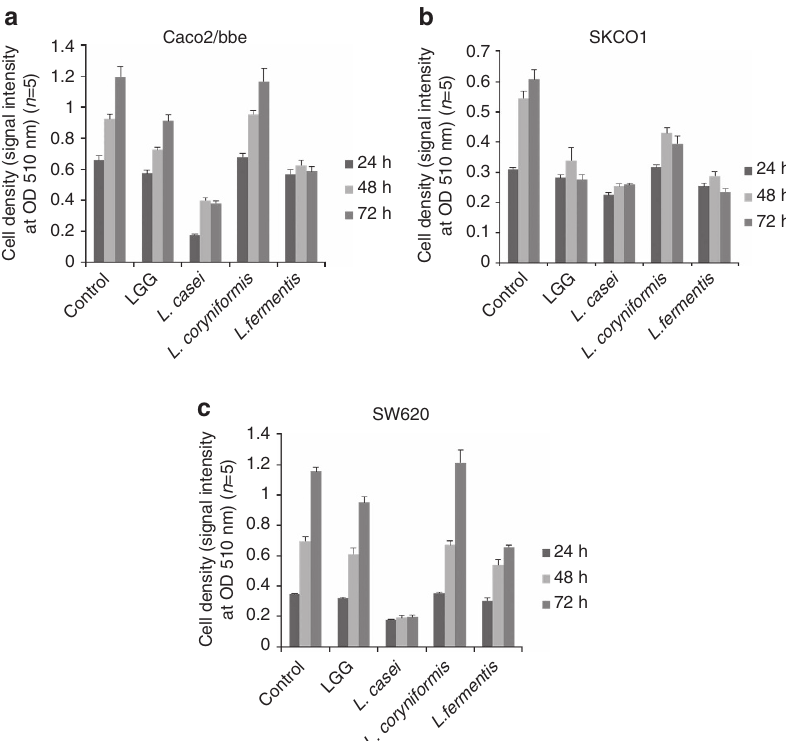
Figure 1 | Conditioned media derived from the Lactobacillus spp. reduced the progression of colon cancer cells. An SRB assay revealed that the numbers of colon cancer cells, Caco2/bbe ( a ), SKCO-1 ( b ) and SW620 cells ( c ), were significantly lower in the conditioned media from the Lactobacillus GG ATCC53103-, L. casei ATCC334 -, L. coryniformis ATCC25600- and L. fermentis ATCC23271-treated groups than in the control group. The strongest tumour-suppressive effect against colon cancer cells was observed in the conditioned media from the L. casei ATCC334 group. The error bars show the s.d. ( n ¼